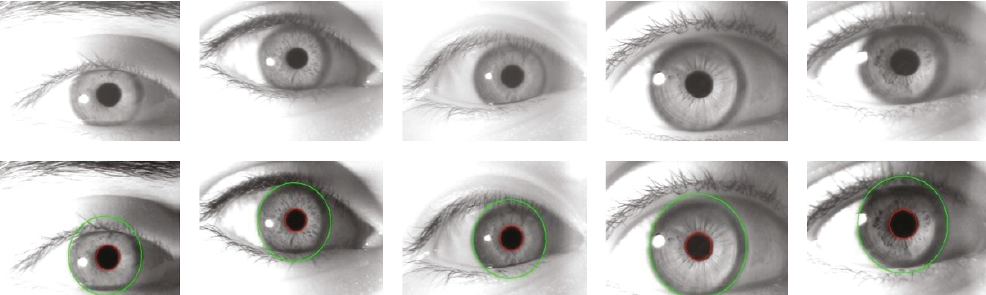
Figure 20: Eye images acquired from various users who were at di ff erent positions within the capture volume are shown in the first row. The second row shows the segmentation results of these images. The segmentation is discussed in Section 3.3.1.